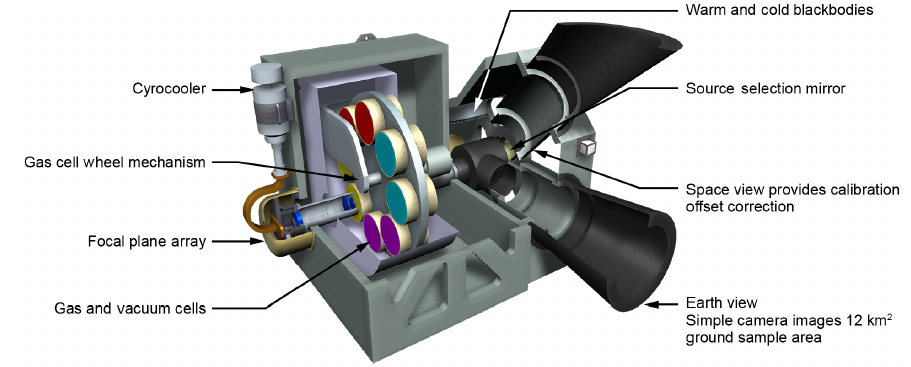
Figure 9. The CHRONOS GFCR is a staring infrared camera with gas cell filters in the optical path. A source selection mirror determines the input to the system (Earth FOV, one of three onboard calibration sources, deep space or closed). Optics image this source input onto a cryogenically cooled large-area focal plane array.